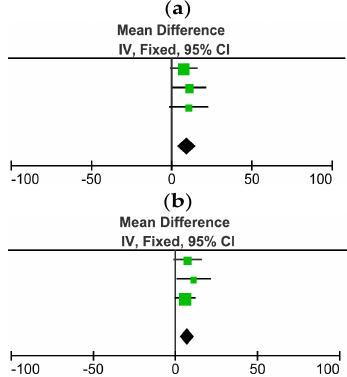
Figure 3. ( a ) Meta-analysis with fixed effect of the mean differences in DIT between MCT and LCT with the margarine trials of Kasai et al. Studies included in this meta ‐ analysis are represented in the figure by symbols (green squares) and they are illustrated in the following order: Clegg et al.